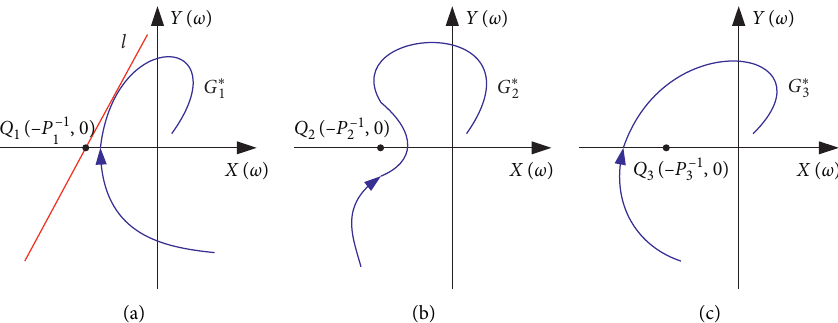
Figure 8: Modified frequency characteristic curves of various systems. (a) Absolute stability system. (b) Unstable system. (c) Unstable system.